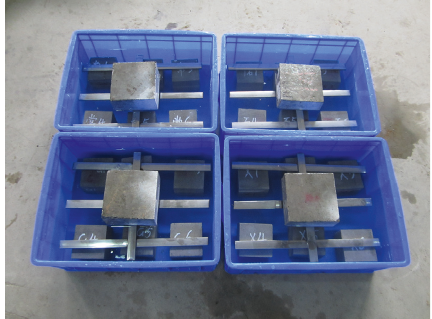
Figure 3: The samples immersed in the sink. Table 2: The main test parameters for different